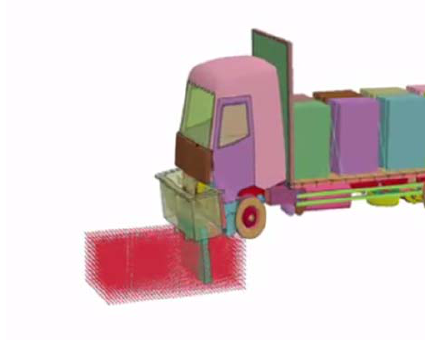
Figure 8 – Anchored barrier Рис . 8 – Анкерный барьер Слика 8 – Фиксна баријера